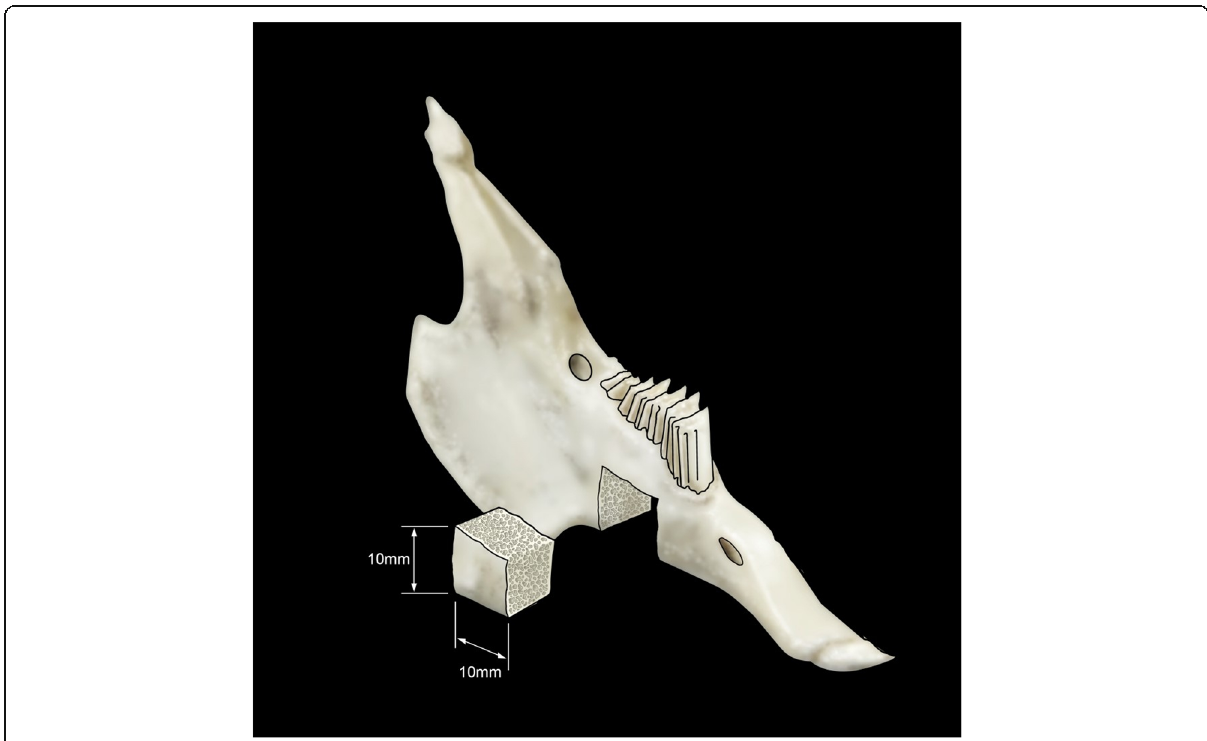
Fig. 1 Schematic drawing showing the segmental bone defect in the rabbit ’ s jaw. The defects were made bilaterally. The segmental mandibular bone defects were made bilaterally and filed with either deproteinized bovine bone mineral with collagen (DBBM-C; Bio-oss ® ) or lyophilized bovine medullary bone (LBMB; Orthogen